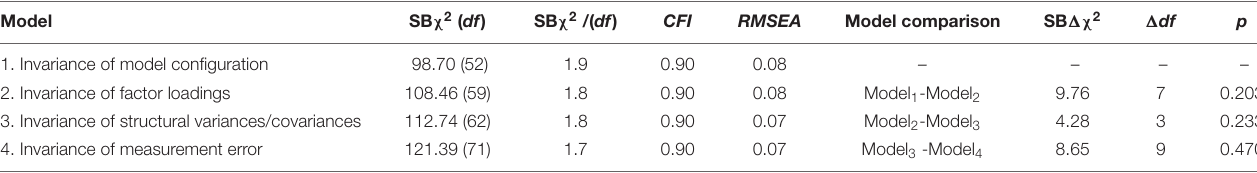
TABLE 3 | Goodness-of-fit statistics for each level of structural and measurement invariance across genders.